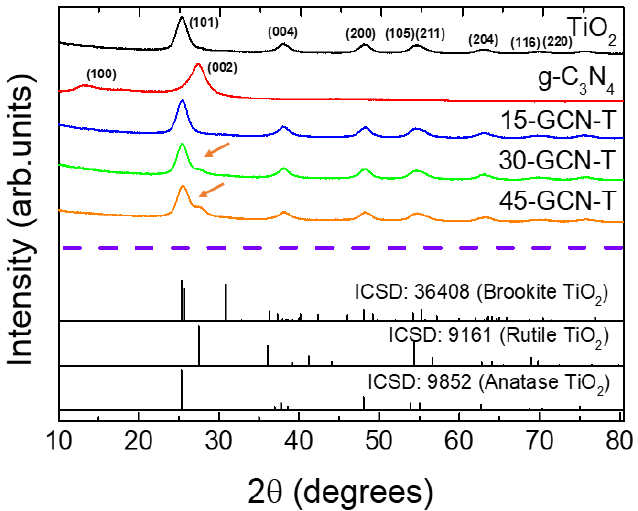
Figure 2. XRD diffractograms of the pure TiO 2 , pure g-C 3 N 4 and heterostructures composed of TiO 2 with different weight loading percentages of g-C 3 N 4 (15-GCN-T, 30-GCN-T and 45-GCN-T). The simulated brookite, rutile and anatase TiO 2 are also shown for comparison. Orange arrows indicate the diffraction maximum at 27º likely associated with the presence of graphitic carbon nitride.